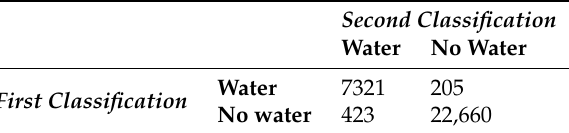
Table 2. Results of the cross-validation. The first classification is a clustering on the whole data set, and the second classification is based on clustering on a subset of data with classification of the residual data set.